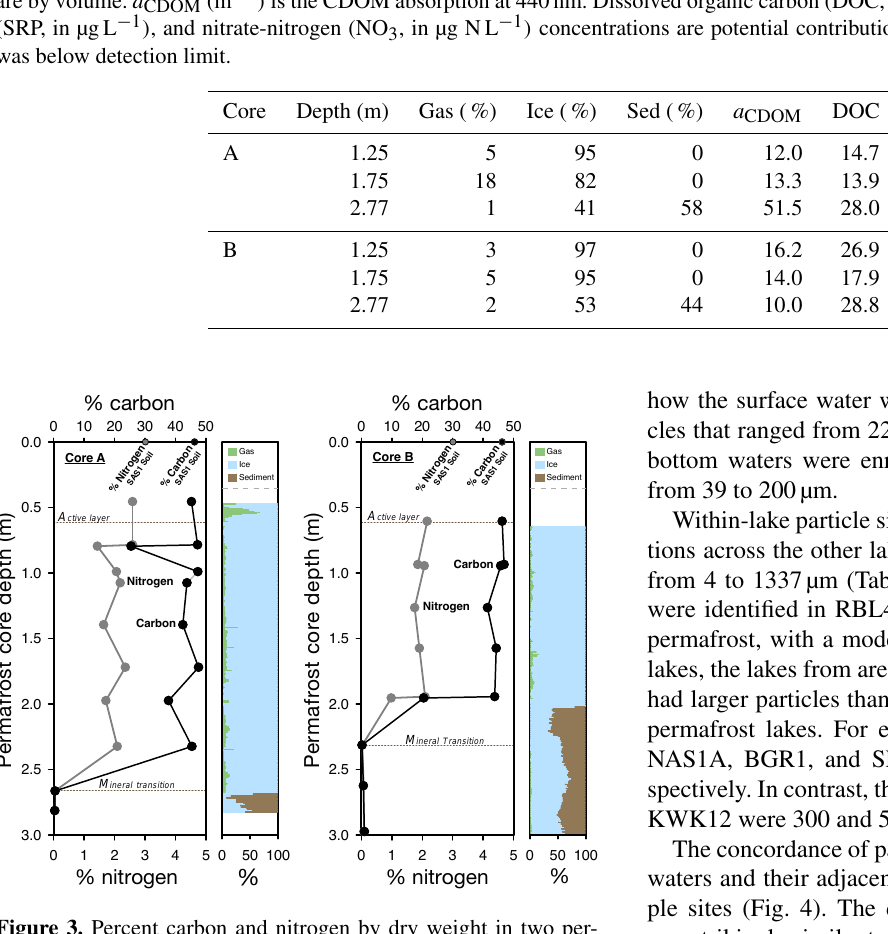
Figure 3. Percent carbon and nitrogen by dry weight in two per- mafrost cores from SAS palsa mounds, and proportions of gas, ice, and sediment by